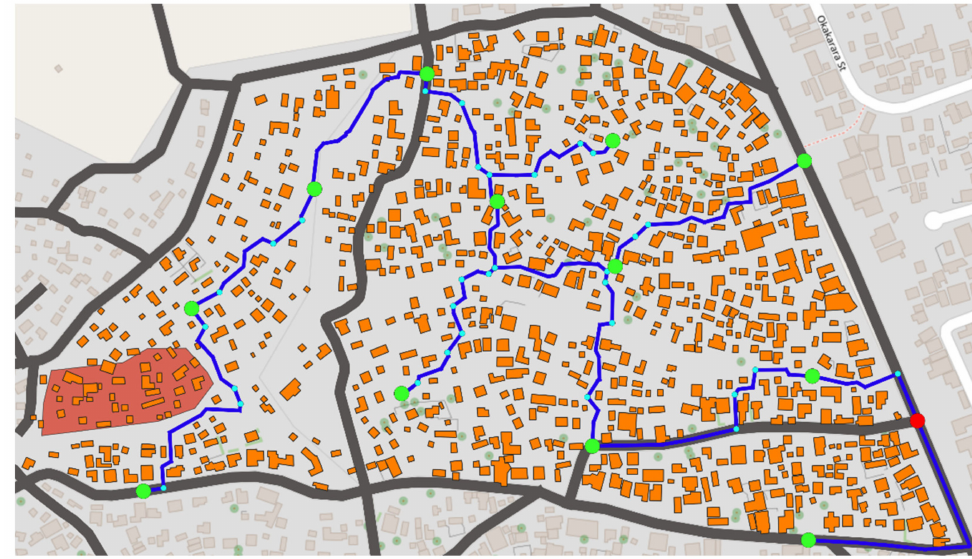
Figure 7. Result of the generated WDS (pipes: blue, water: points green, feeding point: red) without differentiation of ambient conditions (basemap and buildings/polygons: